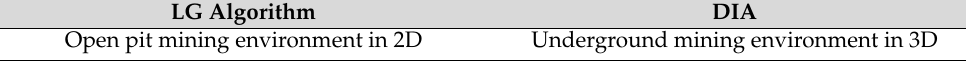
Table 3. Adaptation of the UPL optimisation principles to stope layout optimisation. Source: [3]. LG